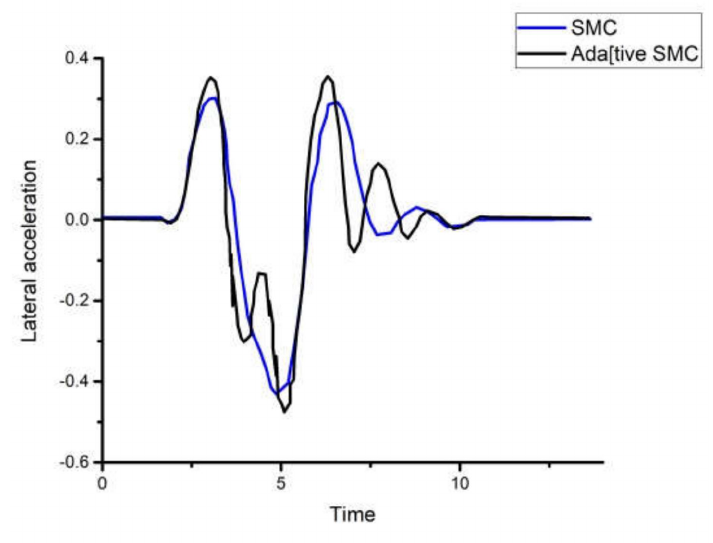
Figure 12. Lateral acceleration.